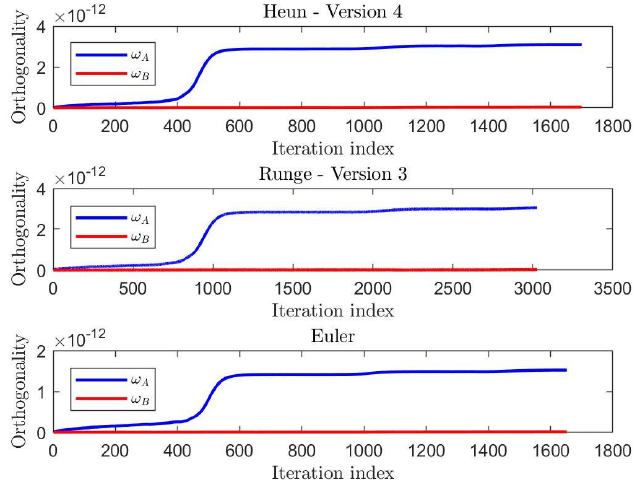
Figure 4. Results of a comparison of the values taken by the discrepancies and the learning criterion during learning by the Heun method, Version 4, the Runge method, Version 3, and the Euler